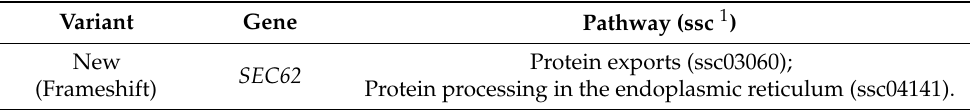
Table 8. Genes with elevated impact variants enriched in metabolic pathways with the KEGG Pathway Database.